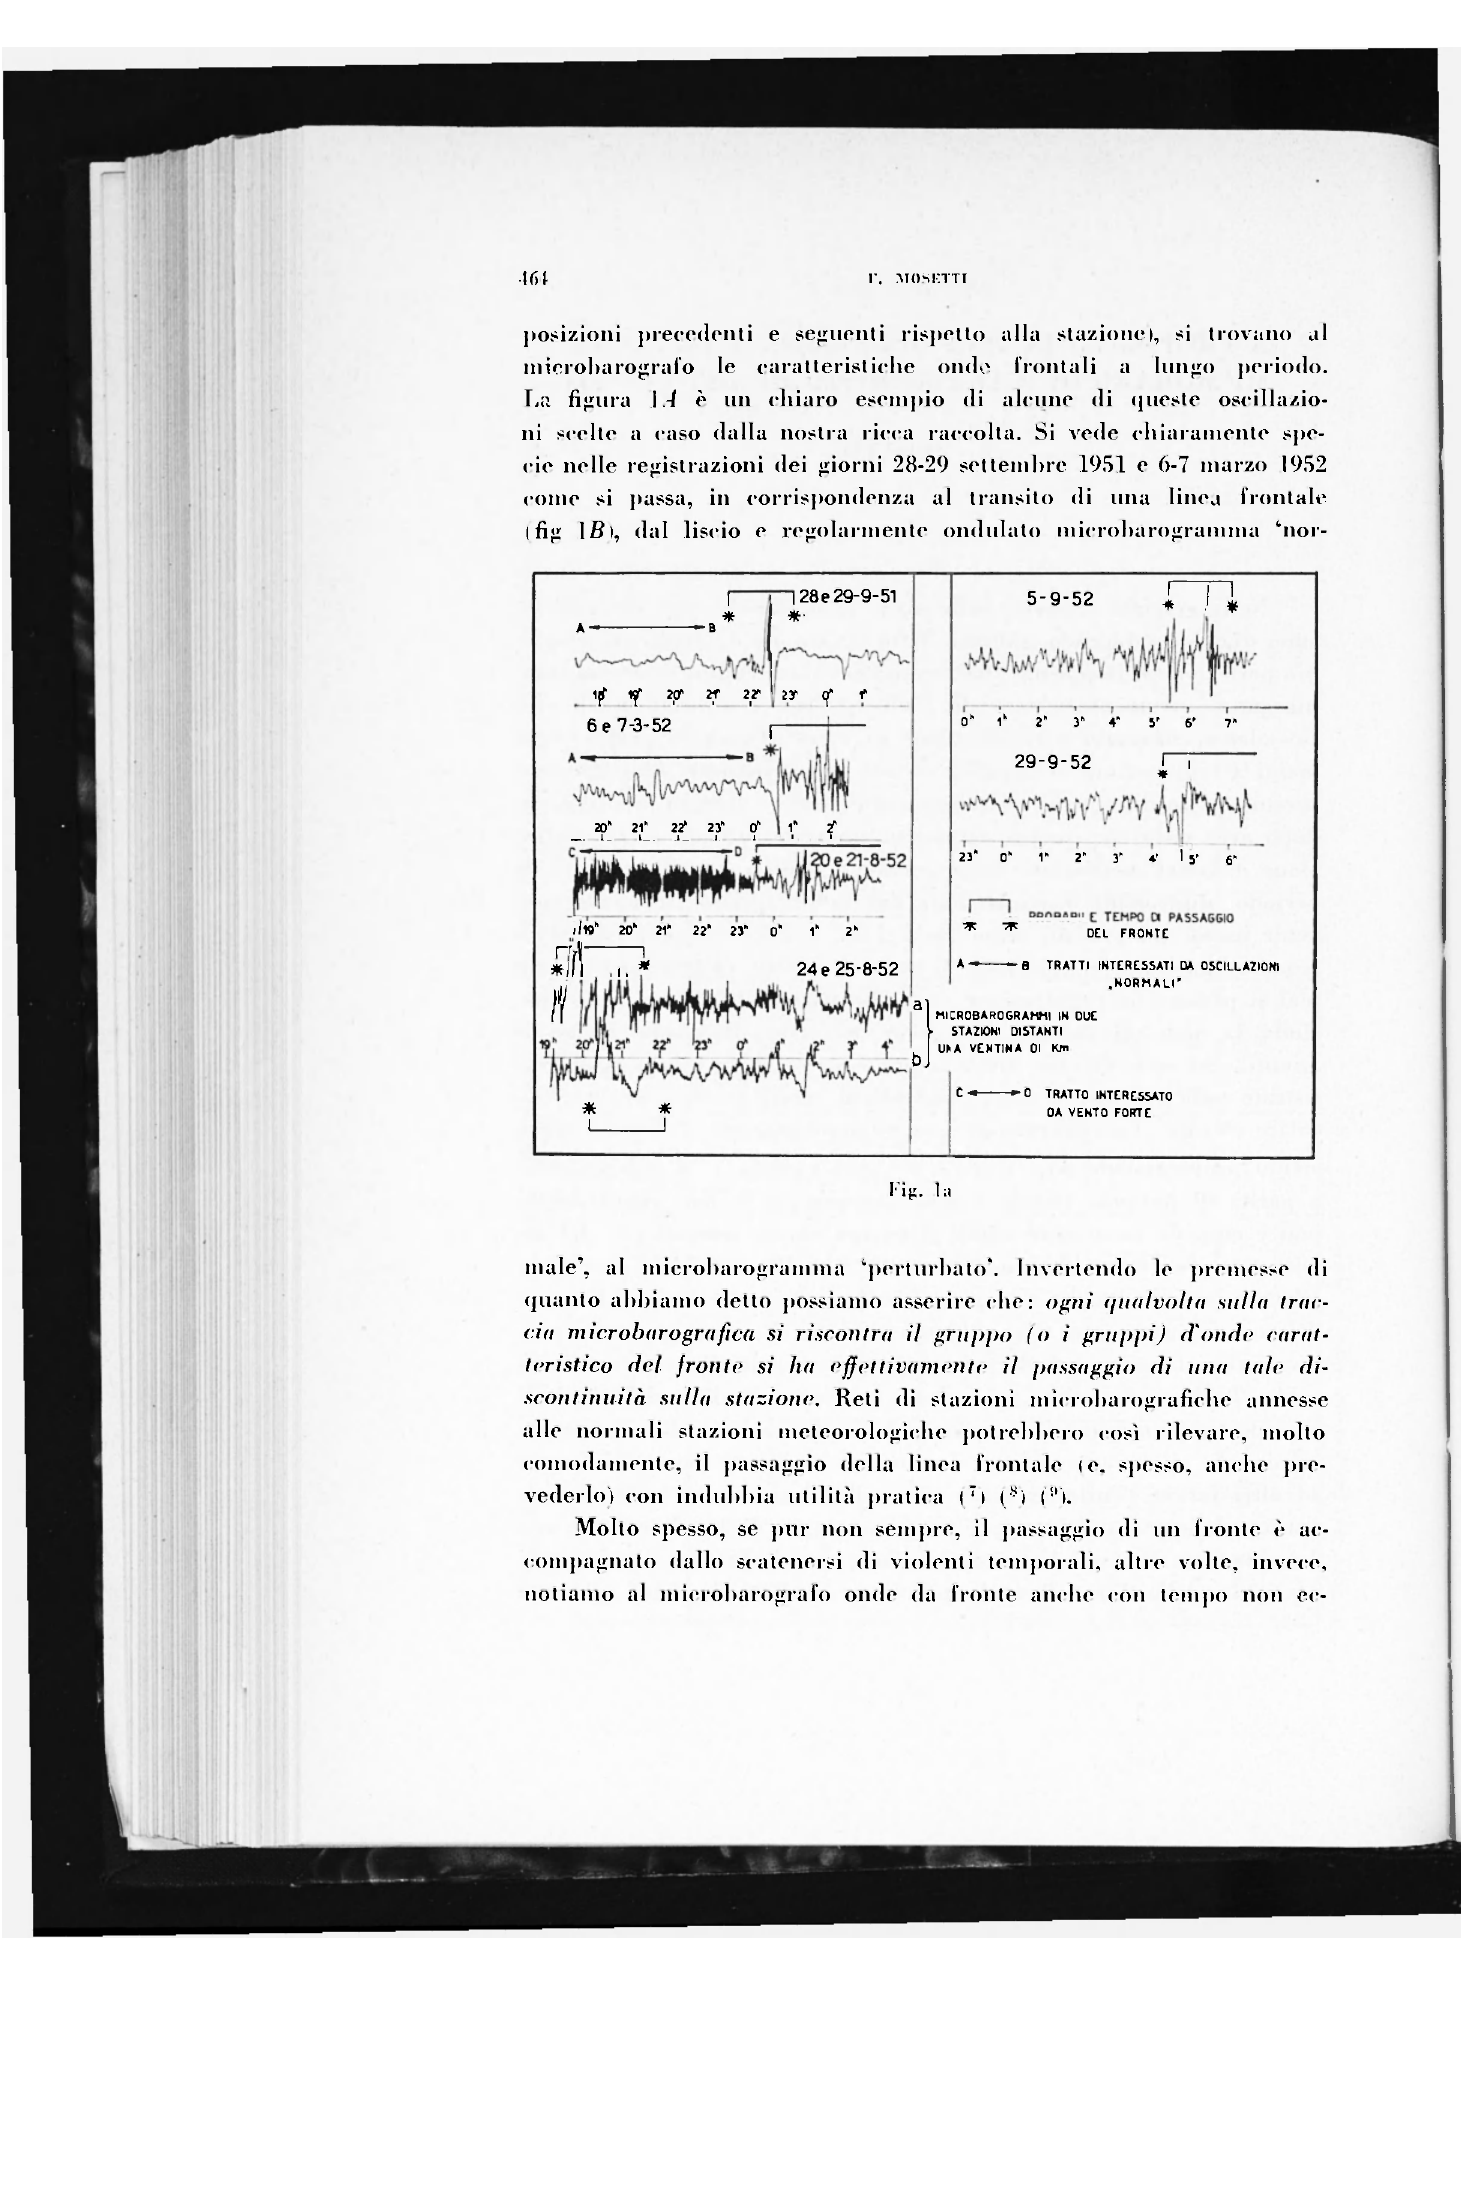
figura di alcune di queste oscillazio- cie nelle registrazioni dei giorni 28-29 settembre 1951 e 6-7 marzo 1952 come si passa, in corrispondenza al transito di una linea frontale I fig lBi, dal liscio e regolarmente ondulato microbarogramma 'nor-